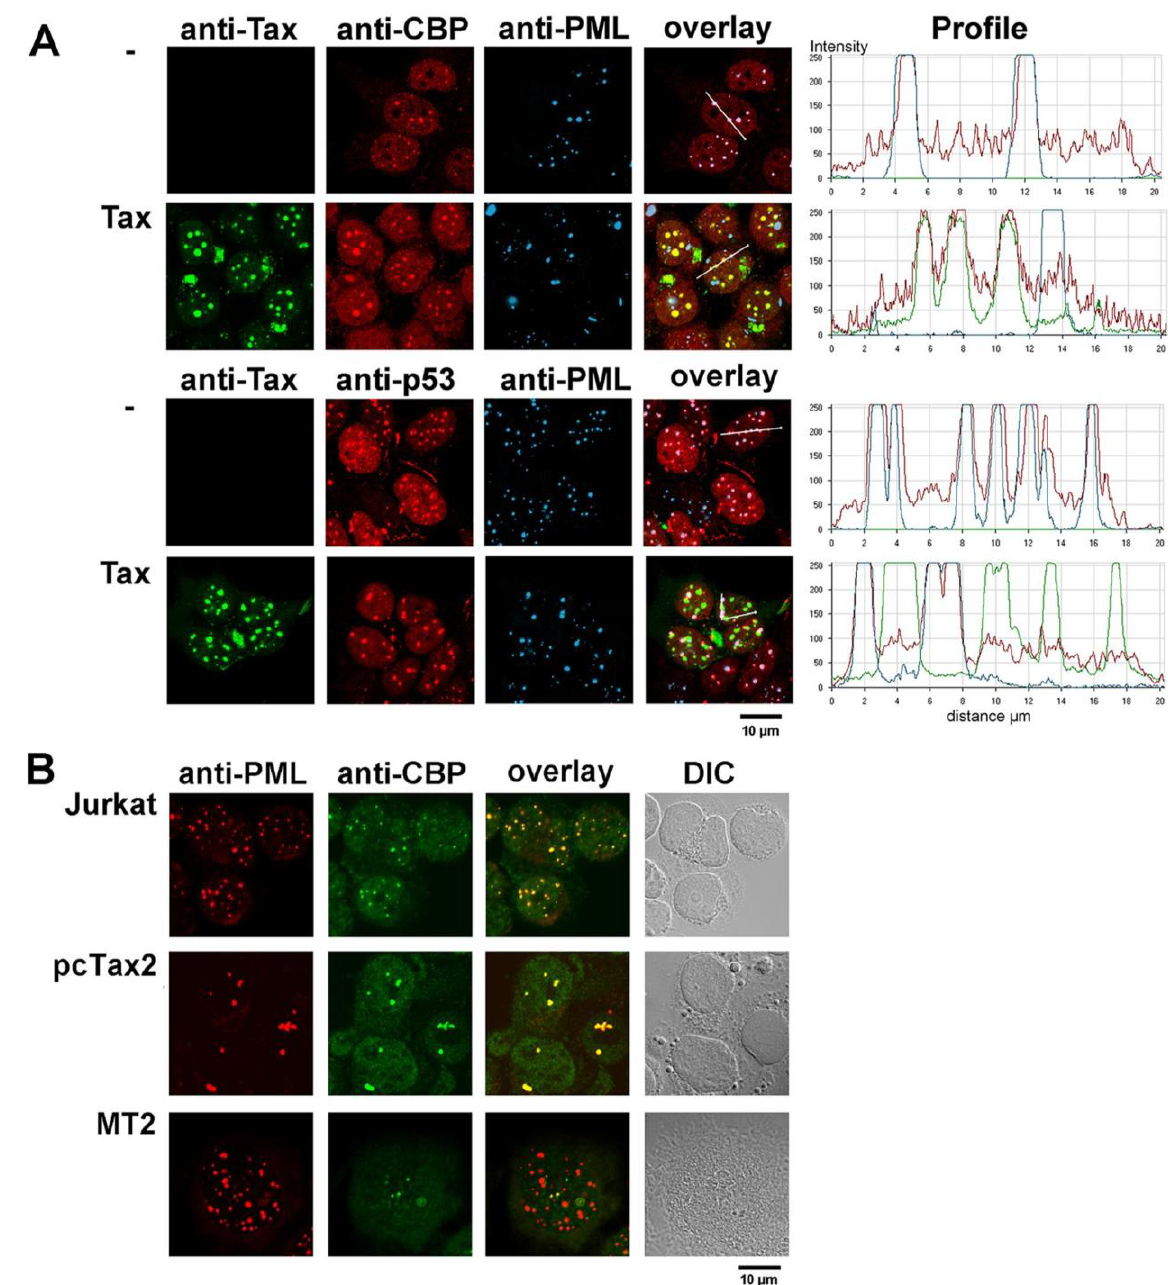
Figure 6. The acetyltransferase CBP is delocalized from the PML NBs to the Tax NBs. ( A ) Triple immunofluorescence staining and confocal microscopy of HEK293 cells both with and without transfection by a Tax expression vector. Either anti-Tax, anti-CBP and anti-PML antibodies or anti-Tax, anti-p53 and anti-PML antibodies were used for the staining, as indicated. The profiles of the intensity of the fluorescence for each staining along a line drawn across the nucleus are shown. ( B ) Dual immunofluorescence staining using anti-PML and anti-CBP antibodies of either uninfected T cells (Jurkat) or IL2-dependent primary lymphocytes immortalized by transfection of a cloned HTLV-1 provirus (pcTax2 [119]) or IL2-independent HTLV-1-transformed T lymphocytes (MT2). DIC, differential interference